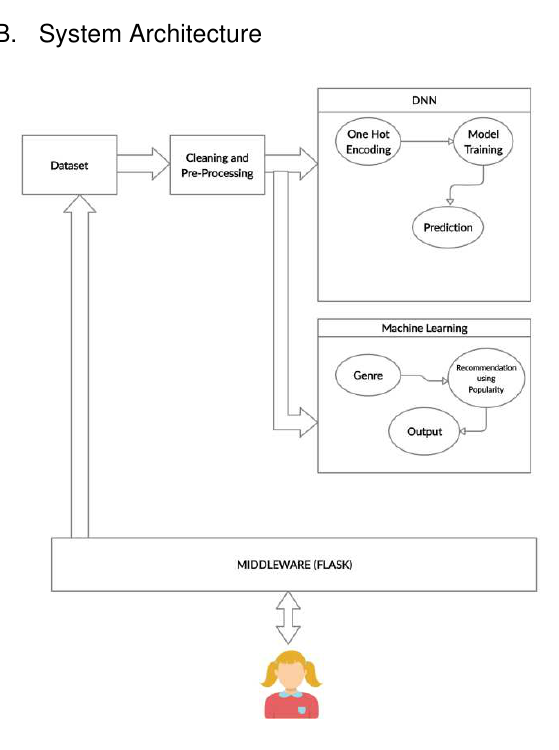
Fig 1. Workflow Chart